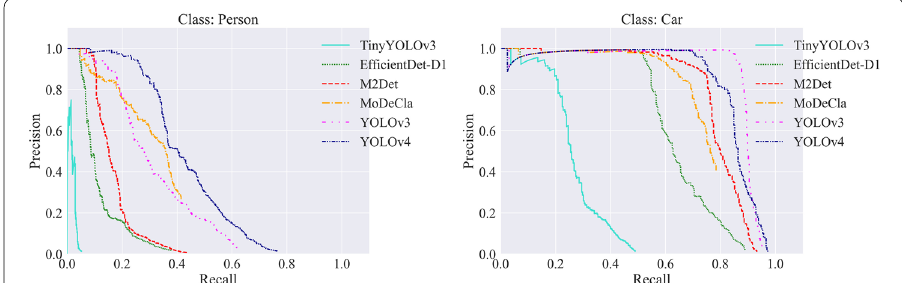
Fig. 6 Traditional precision-recall curves for the detectors on the Summer benchmark